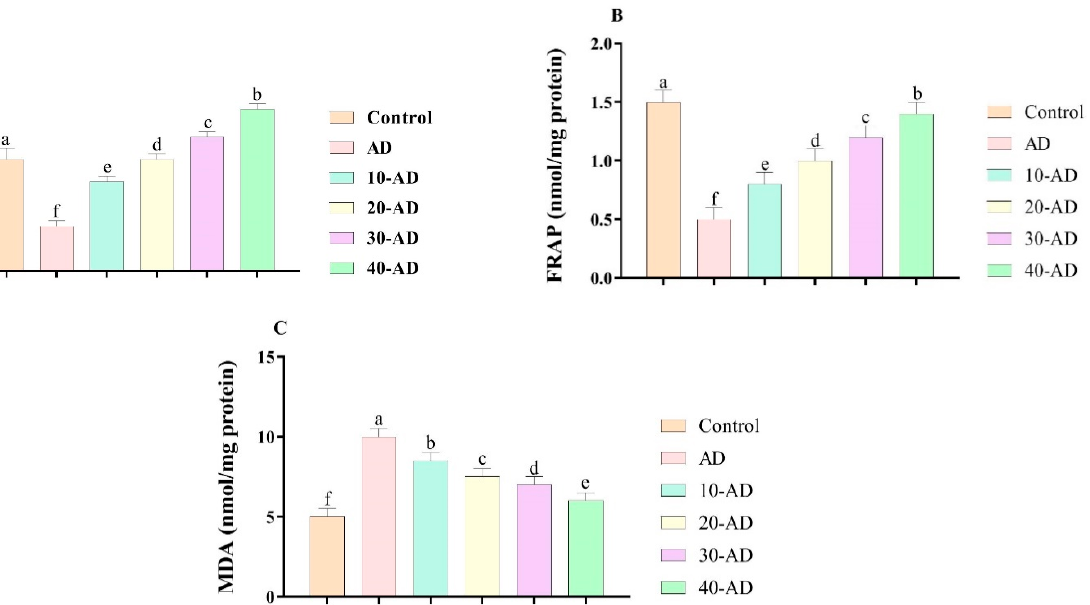
Figure 4. The effects of sake yeast on biochemical parameters in rats with Alzheimer. ( A ) BDNF; ( B ) FRAP and ( C ) MDA. Superscript symbols (a–f) show significant differences between groups.